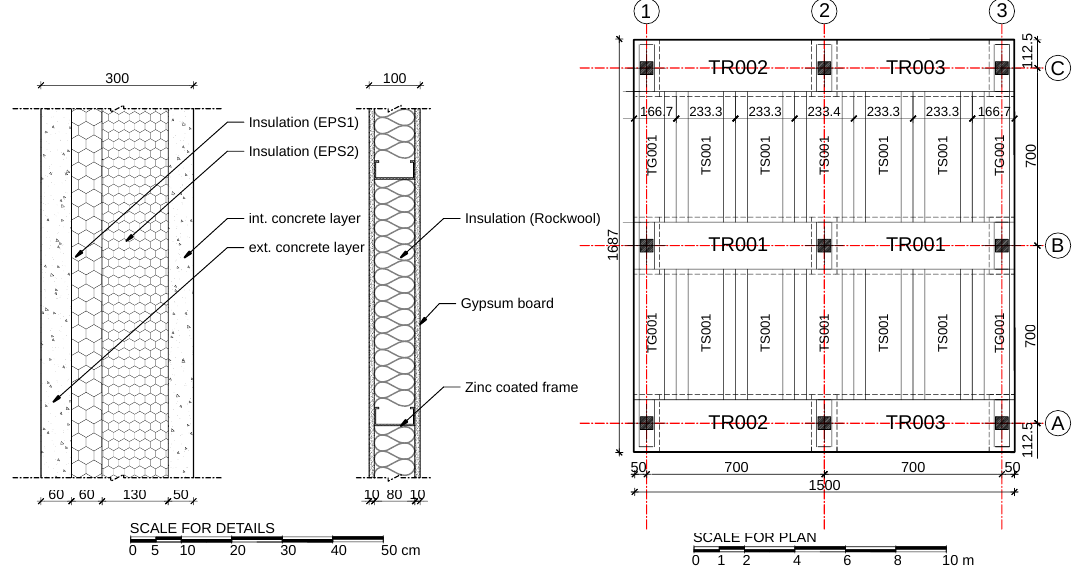
Figure 7. Cross section of the internal and the external precast panel.